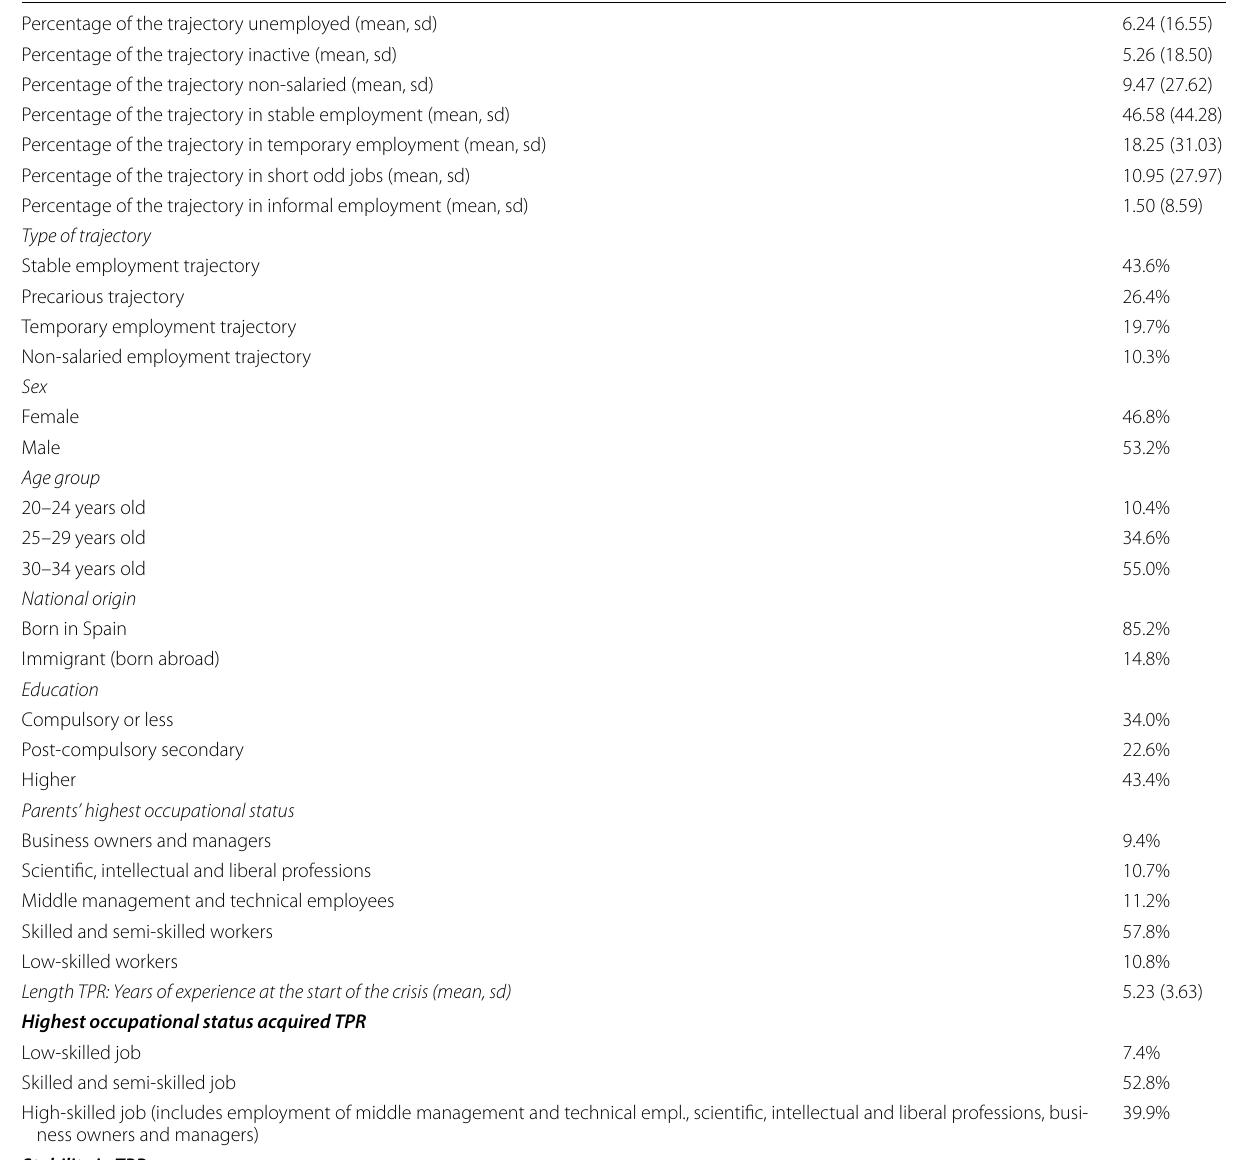
Table 4 Summary statistics for the variables in the